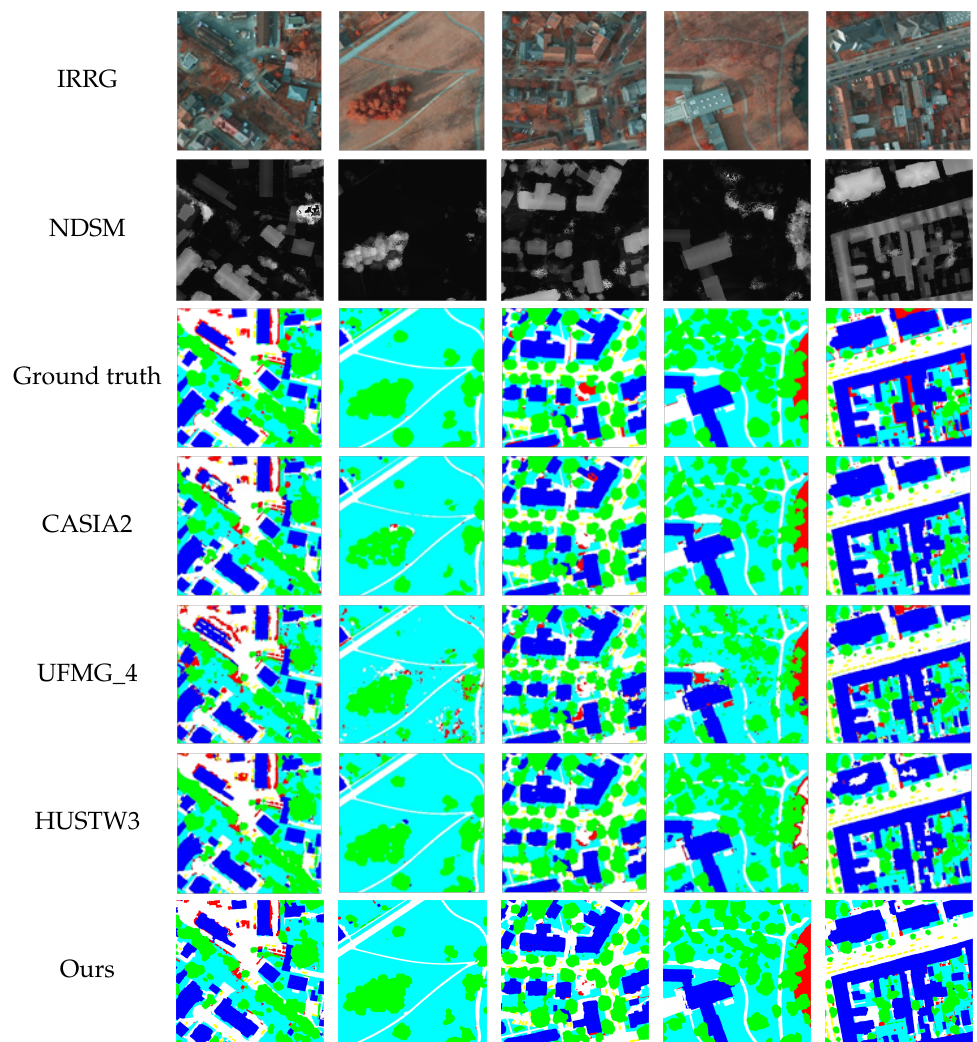
Figure 11. Some examples of the results of the test set on the ISPRS Potsdam dataset. The LANet, CGFDN, BAM-UNet-sc, MACANet and SAGNN currently have no published code and complete test set results